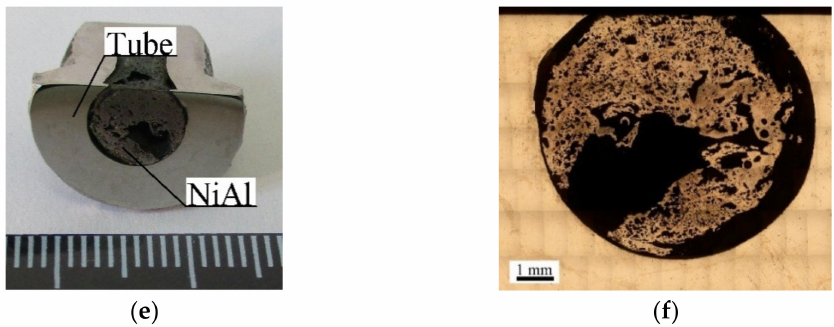
Figure 7. Photographs of structures of segment II: ( a , b ) upper part (ampoule No. 1); ( c , d ) lower part (ampoule No. 1); ( e , f ) lower part (ampoule No. 2). Figure 8a,b show the SEM image and the results of the EDS analysis of the upper part of segment II of ampoule No. 1. It was found that the upper part of the sample consisted of a NiAl phase containing up to 20 at.% Fe and 5 at.% Cr [36]. The lower part of the sample consisted of Ni–Al in the form of a compacted powder mixture. The synthesis products were detected only in the center of the sample in the region of 300 µ m in diameter (Figure 8c). According to the EDS analysis results (Figure 8d), the new phase (in the central region) also consisted of NiAl and other elements (up to 10 at.% Cr and up to 40 at.% Fe). Figure 8e,f show the SEM image of the lower part of ampoule No. 2 and the results of EDS analysis. It was found that the entire powder sample in segment II consisted of NiAl.